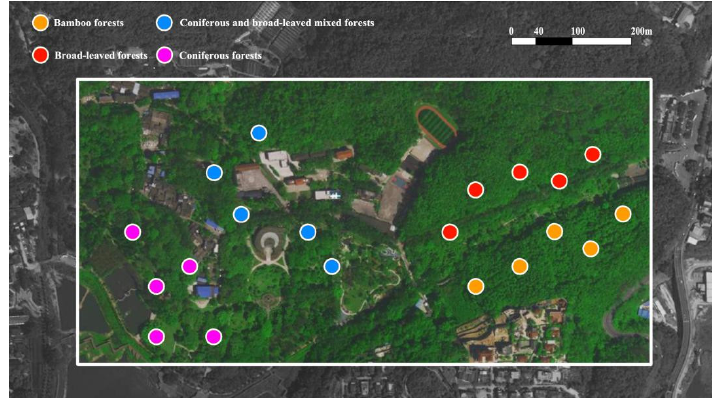
Figure 1. Observation sites in study